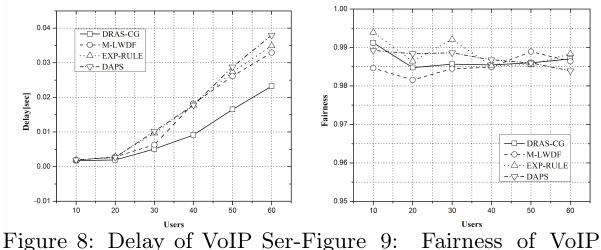
Figure 6: Throughput of VoIP Service